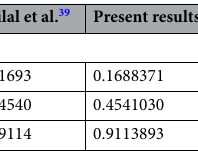
0.35, (cid:31) 0, γ 0, Fr 0.5, ∗ = = = =